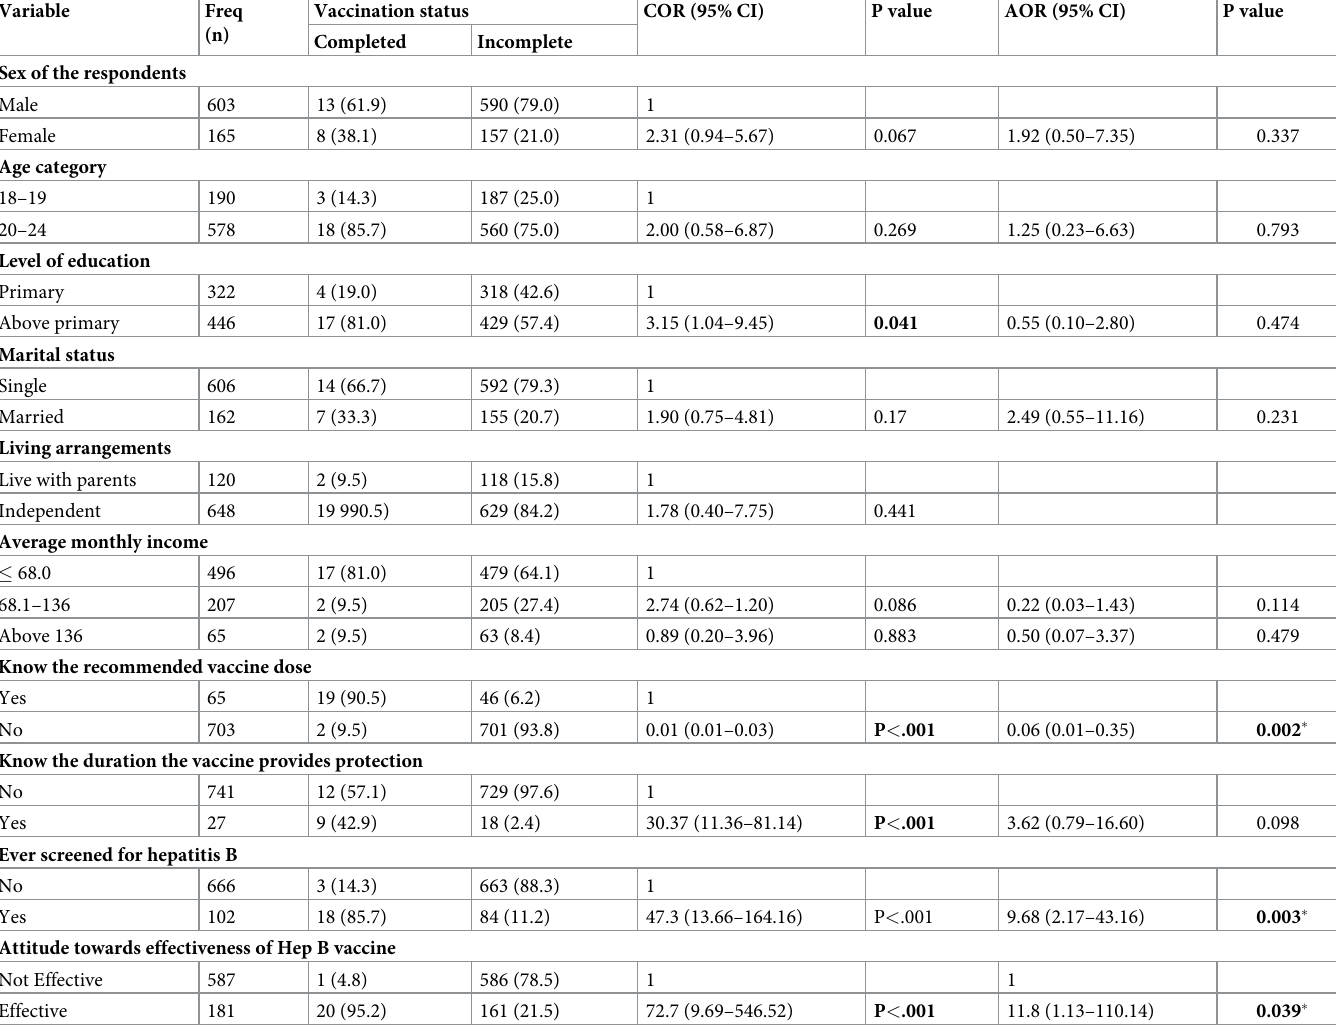
Table 3. Predictors of the hepatitis B vaccination status of young psychoactive substance users in Kampala,